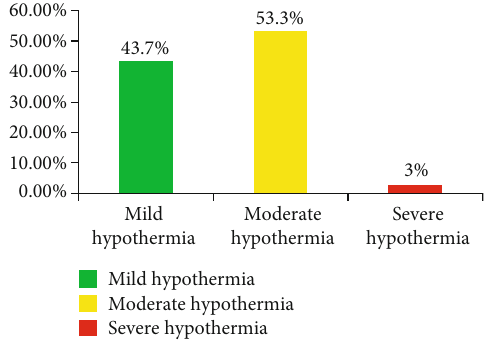
Figure 2: Distribution of hypothermic neonates in relation to degree of hypothermia in Dessie Referral Hospital, Northeast Ethiopia, 2018 ( N = 202 ).